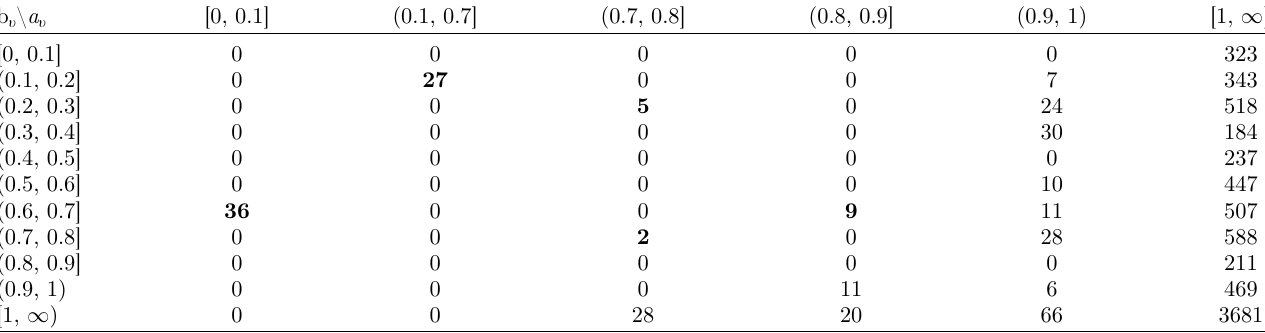
Table 14. Number of clients by interval, a t given by equation (6) and b t given by equation (7). In bold the number of cases with high risk.